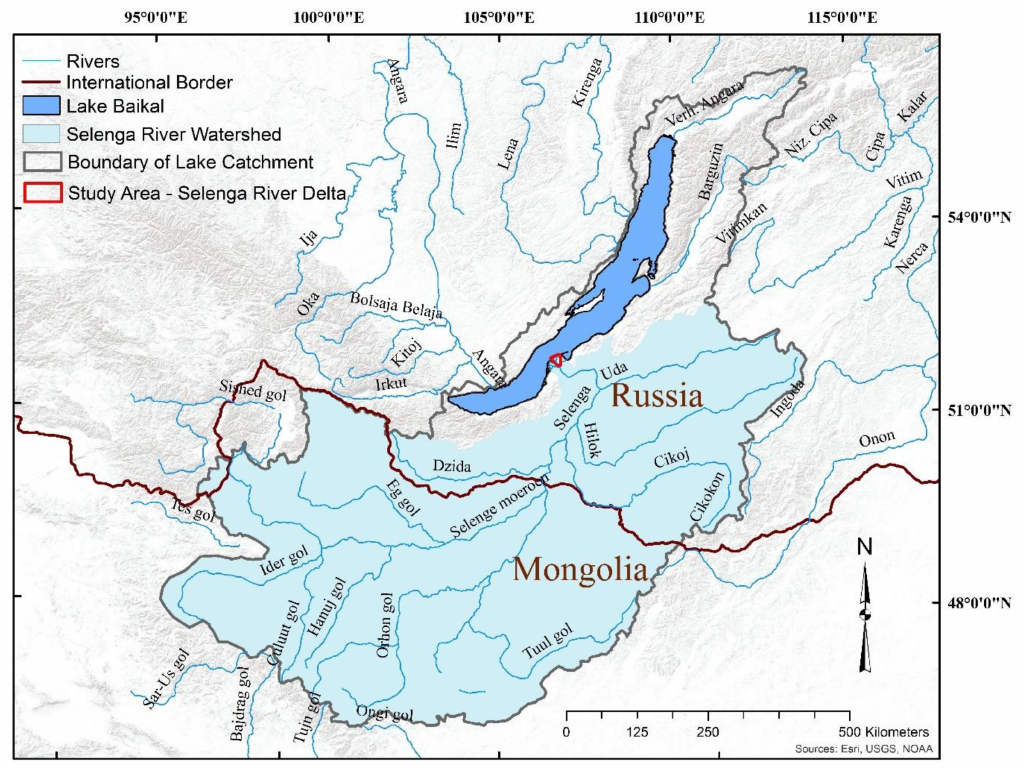
Figure 1. The watershed contributing to the study area, the Selenga River Delta into Lake Baikal,